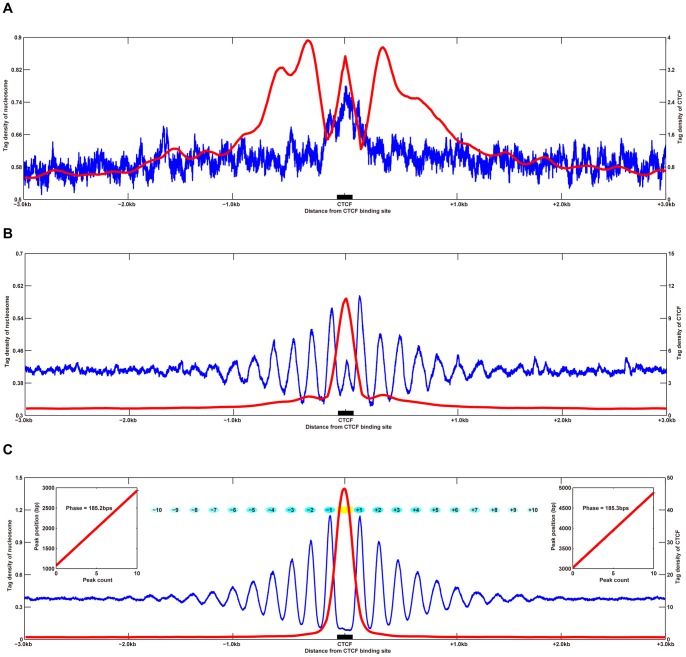
Nucleosome positioning near the CTCF-binding sites in K562 cells.Nucleosome (blue lines) and CTCF-binding sites (red lines) profiles around cell type-specific (A), common (B), and ubiquitous (C) CTCF-binding sites are illustrated. Distances from the CTCF-binding sites are plotted along the x-axis. Left and right y-axes represent the normalized tag densities of the nucleosome and CTCF-binding sites, respectively. In (C), cyan ovals depict hypothetical nucleosome positions across the site with color intensities reflecting their positioning strength. The CTCF-binding site is indicated by the yellow rectangle. Left inset, linear fit to the positions of the phase peaks within 3 kb downstream of the CTCF-binding sites (slope  = 185.2 bp; 95% confidence interval (CI)  =  [184.6 bp, 185.7 bp]). Right inset, linear fit to the positions of the phase peaks within 3 kb upstream of CTCF-binding sites (slope  = 185.3 bp; 95% CI  =  [184.2 bp, 186.5 bp]).